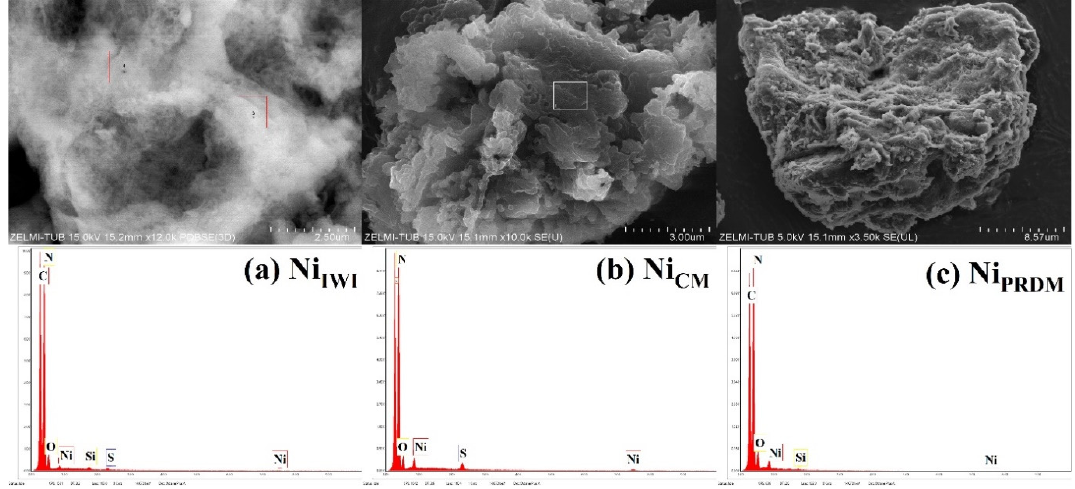
Figure 3. SEM images and EDX spectra of Ni-loaded ex-g-CN synthesized using the ( a ) incipient wet impregnation (IWI) method, ( b ) colloidal method (CM), and ( c ) precipitation deposition method (PRDM).